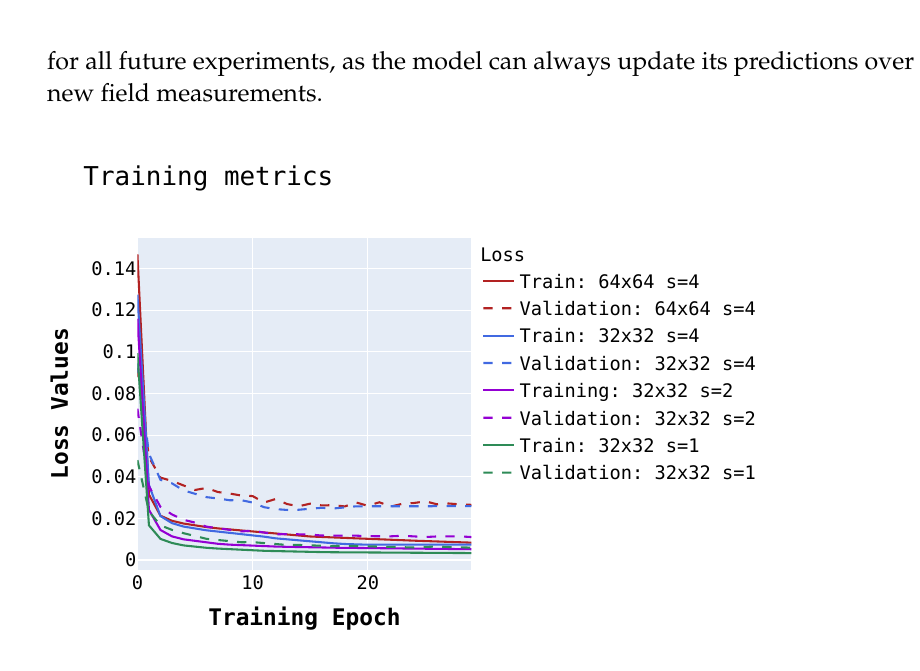
Figure 6. Training and Validation (MSE) Losses for 30 epochs for models trained with δ = 64, s = 4 and δ = 32, s = { 1,2,4 } . We observe that the loss rates are correlated to the observation intervals for input sequence. This is attributed to the fact that the architecture’s prediction performance is heavily dependent on recognizing temporal patterns in pasture growth due to the highly dynamic nature of pasture evolution.